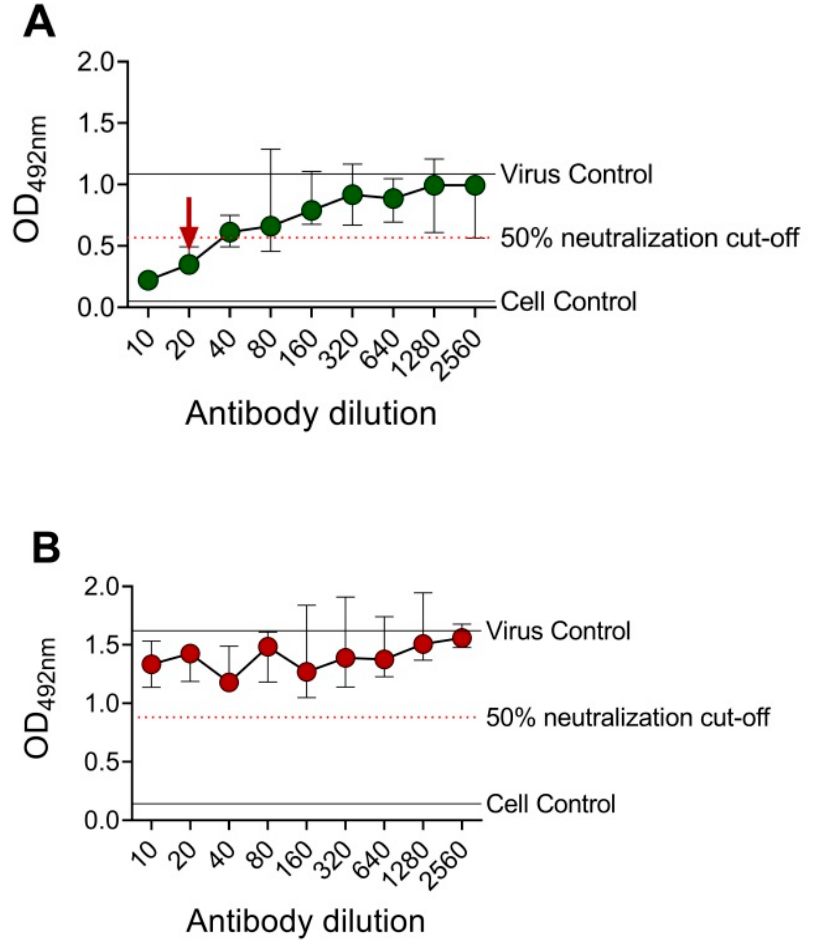
Figure 2. Sample EMNT results of an anti-E mouse monoclonal antibody tested against DENV-2. DENV-2 type-specific mouse monoclonal antibody, 3H5, was tested against DENV-2 DHF0663 using BHK-21 cells ( A ) and Fc γ RIIA-expressing BHK-21 cells ( B ). The neutralizing titer is the reciprocal of the highest antibody dilution that achieved ≥ 50% virus neutralization, as indicated by the arrow. No neutralization was observed when EMNT was performed using Fc γ RIIA-expressing BHK-21 cells. Each data point represents the median value of duplicates ran independently thrice. Error bars indicate 95% confidence interval of six replicates.